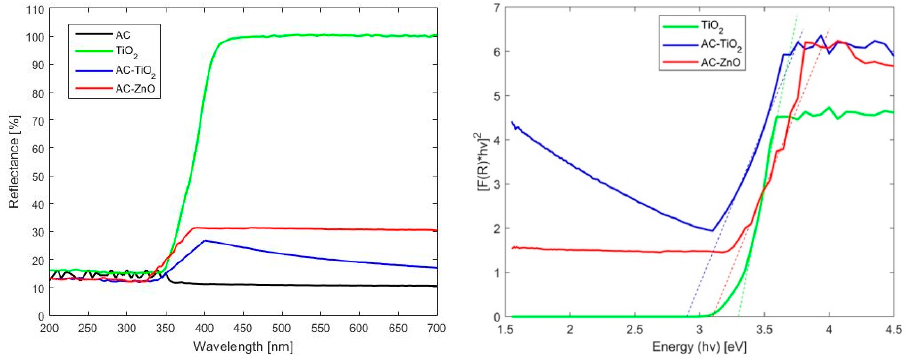
Figure 6. From left to right, DRS spectra and Tauc’s plot.